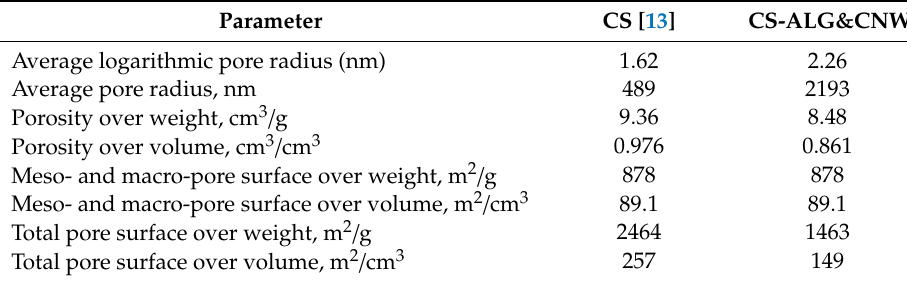
Table 3. Porosity of the sca ff olds.